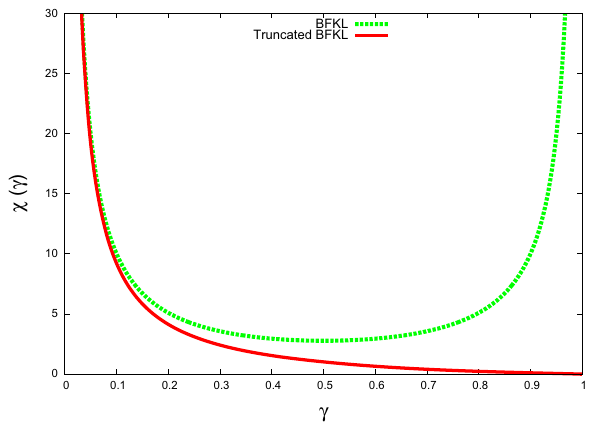
Fig. 17 Collinear behaviour of the BFKL and the truncated BFKL gluon Green’s functions